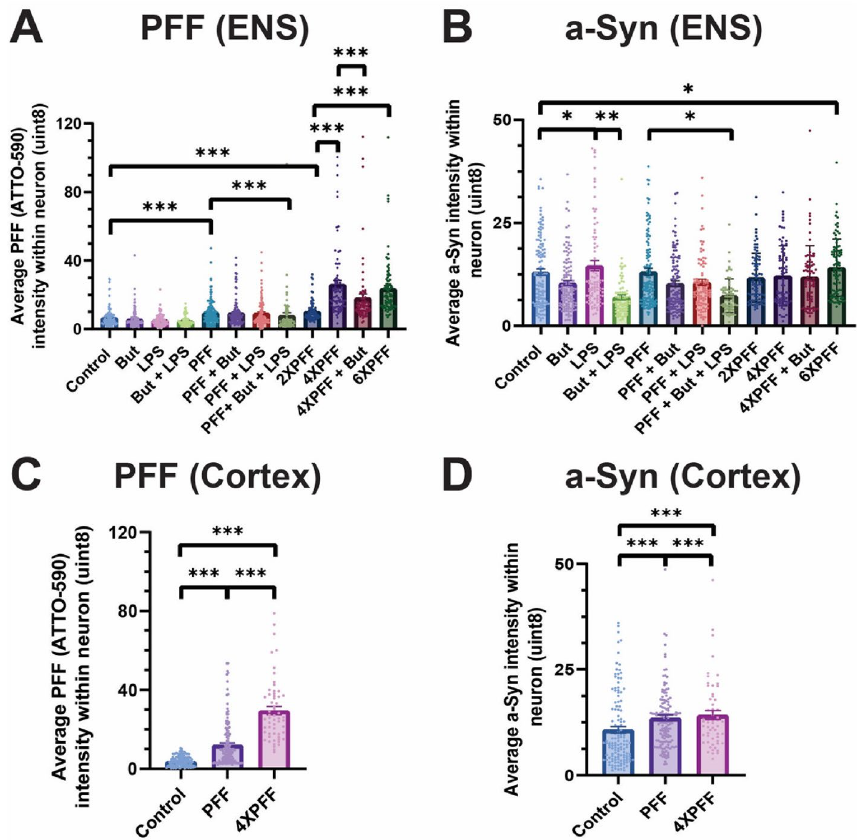
Figure 4. Quantification of preformed fibril (PFF) tag and aggregated α-synuclein (a-Syn) intensity throughout experiments. 2.5 mM of Butyrate (But) and 5 µg/mL lipopolysaccharide (LPS) were added with every feeding following PFF administration. The average intensity of ( A ) PFF and ( B ) aggregated a-Syn within ENS neuron morphology. Sample size ENS: N = 3–7, m = 9–18, images = 60–123. The average intensity of ( C ) PFF and ( D ) aggregated a-Syn within cortical neuron morphology. Sample size cortex: N = 4–8, m = 12–27, images = 57–131. Pixel intensity in uint8 (values range from 0 to 255). Each dot represents an image, and error bars = SEM. Statistical analysis was conducted using a 6th root transformation multilevel model adjusting for experimental replicate and well ( A ) or experimental replicate alone ( B – D ) with Tukey p-value adjustment (* p < 0.05, ** p < 0.01, *** p <